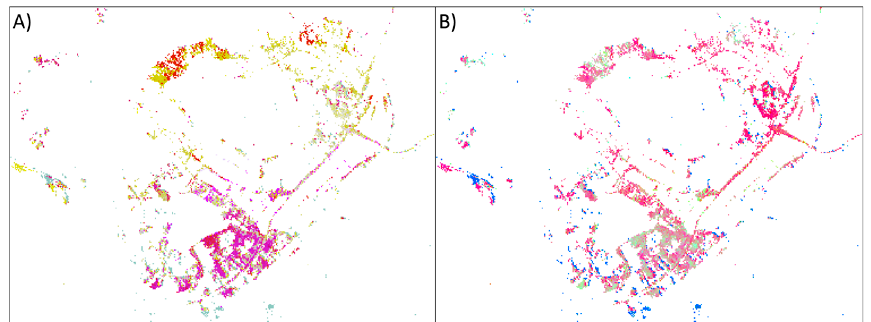
Figure 5. Lítov: MNF1/MNF2/MNF3 images displayed as RGB: ( A ) Scenario 1 (absorption feature parameters derived only from the HyMap data were used); ( B ) Scenario 2 (absorption feature parameters derived from both datasets, HyMap and AHS, were used), the MNF bands were further visually analysed to identify training areas (ROIs) representing different material/surfaces.